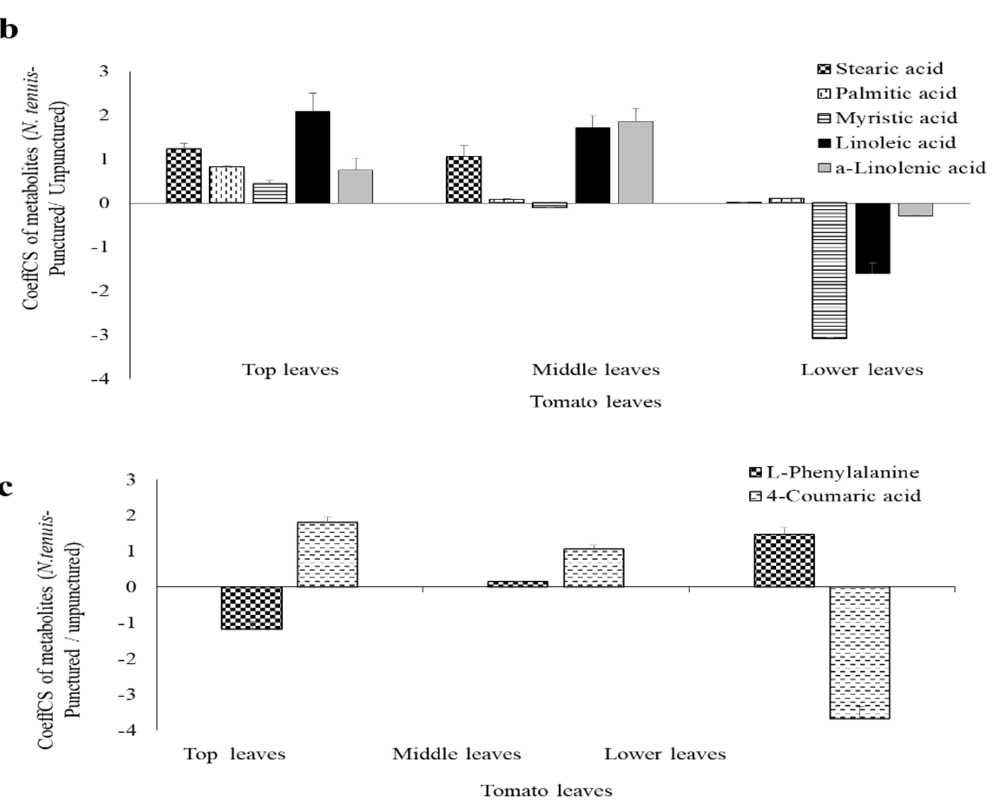
Figure 6. Effect of the N. tenuis -treatment in metabolites related to ( a ) glycolysis and Krebs’s cycle ( b ) fatty acids metabolism and ( c ) shikimate pathway. Positive or negative values of scaled and centered regression coefficients (CoeffCS) indicate upregulation or downregulation of the selected metabolites in N. tenuis -punctured, in comparison to unpunctured plants, respectively.